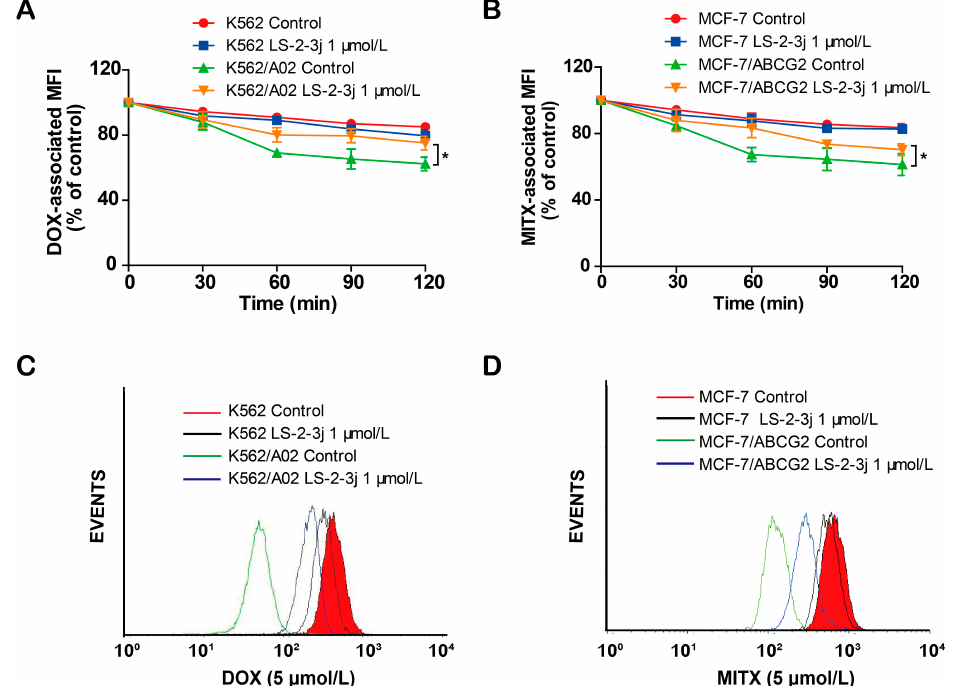
Figure 2. Effect of LS-2-3j on the intracellular accumulation of DOX and MITX in K562 ( A ), K562/A02 ( B ), MCF-7 ( D ), and MCF-7/ABCG2 cells ( E ). The cells were exposed to DOX (5 µ mol/L) and MITX (5 µ mol/L) in the absence or presence of different concentrations of LS-2-3j for 1 h. ( C , F ) The DOX- and MITX-associated mean fluorescence intensity (MFI) in K562/A02, MCF-7/ABCG2 cells, and their parental cells was measured by flow cytometric analysis. The results are presented as fold change to the control group. Each bar represents the mean ± SD of three independent experiments. * p < 0.05, ** p < 0.01, *** p < 0.001 vs. the control group.